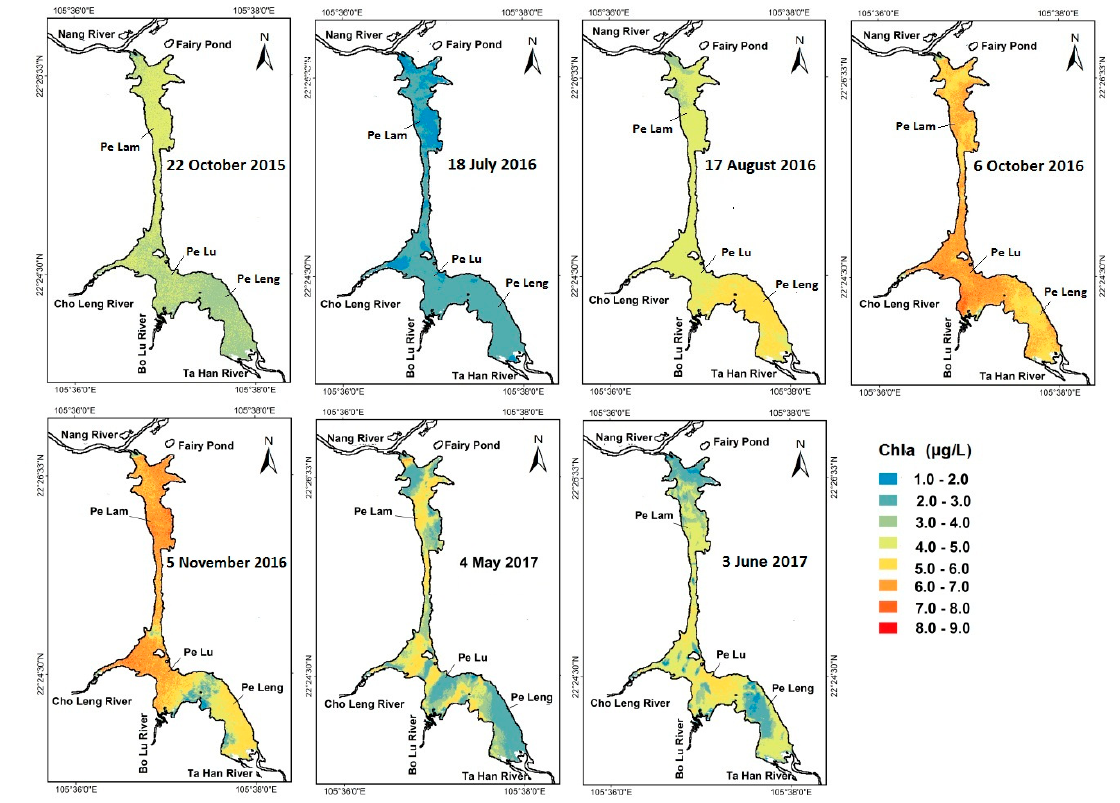
Figure 7. Chla distribution estimated from Equation (4) and the seven S2A images acquired on seven dates (day/month/year) with clear sky and calm wind conditions over Lake Ba Be since 2015.